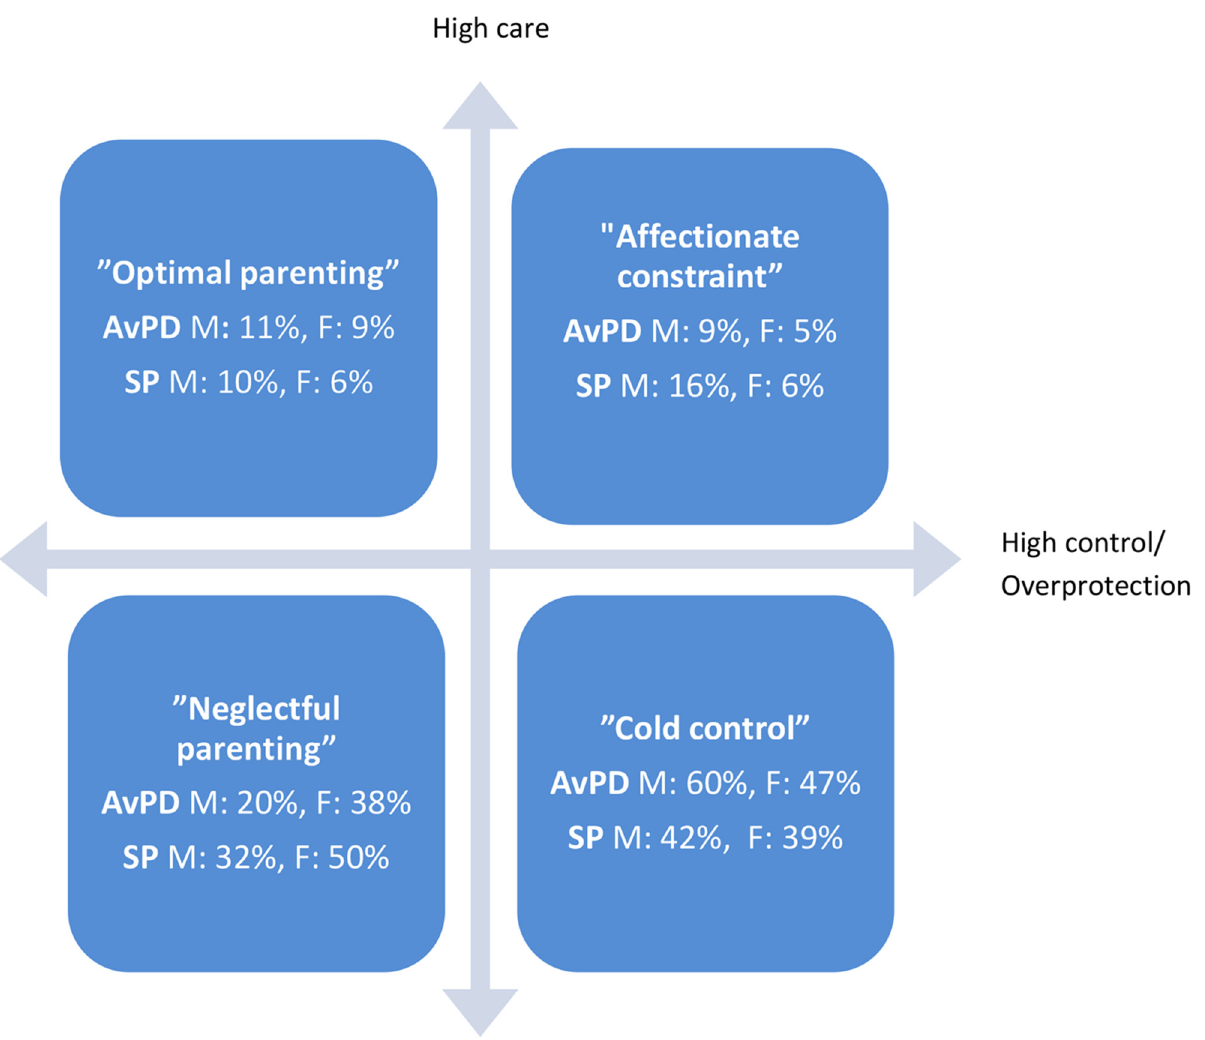
Fig 1. Self-reported parental style in the AvPD and SP groups. Distribution of the AvPD and SP groups in the two dimensional, four categorical parental style model according to the Parental Bonding Instrument (PBI). ORIGO is defined as the cut-off scores, se text. AvPD: Avoidant personality disorder, SP: Social phobia, M: Mother, F: